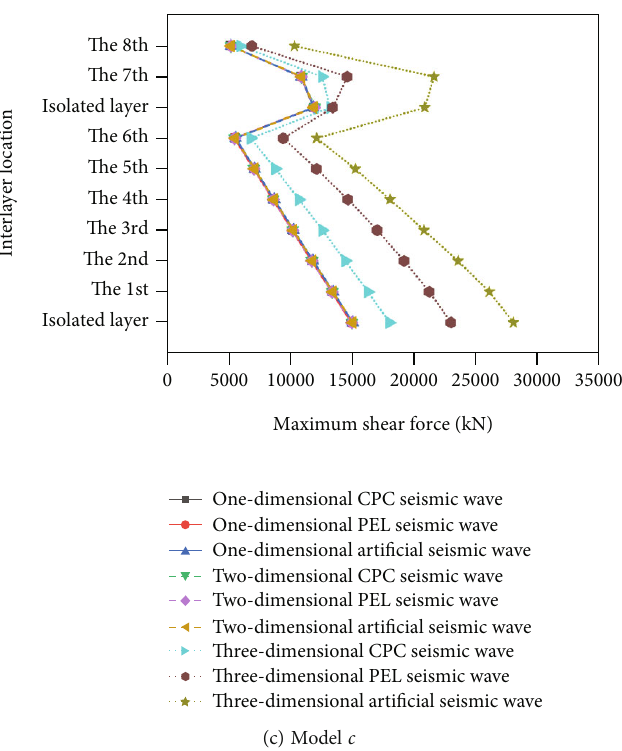
Figure 9: Comparison of the maximum axial force between di ff erent